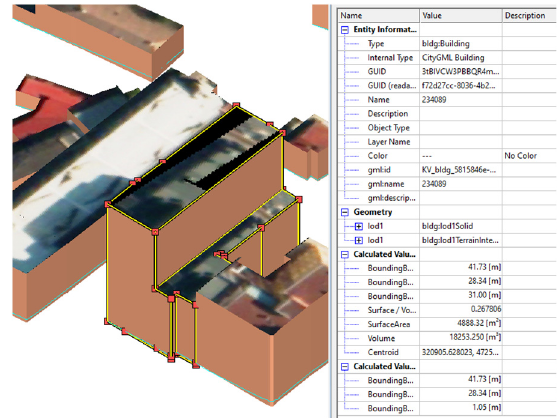
Figure 8. Building modeled as a single solid with differentiated rooftops.